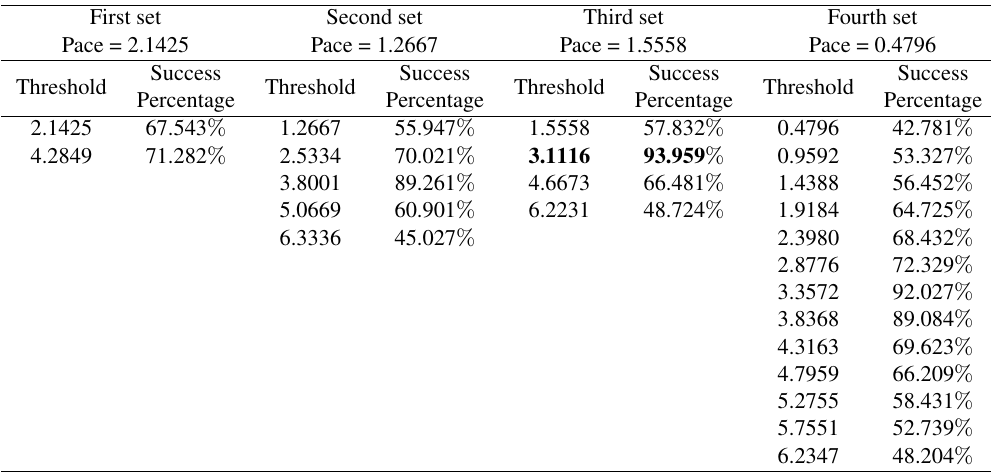
Table 3: Results of threshold selection with the proposed